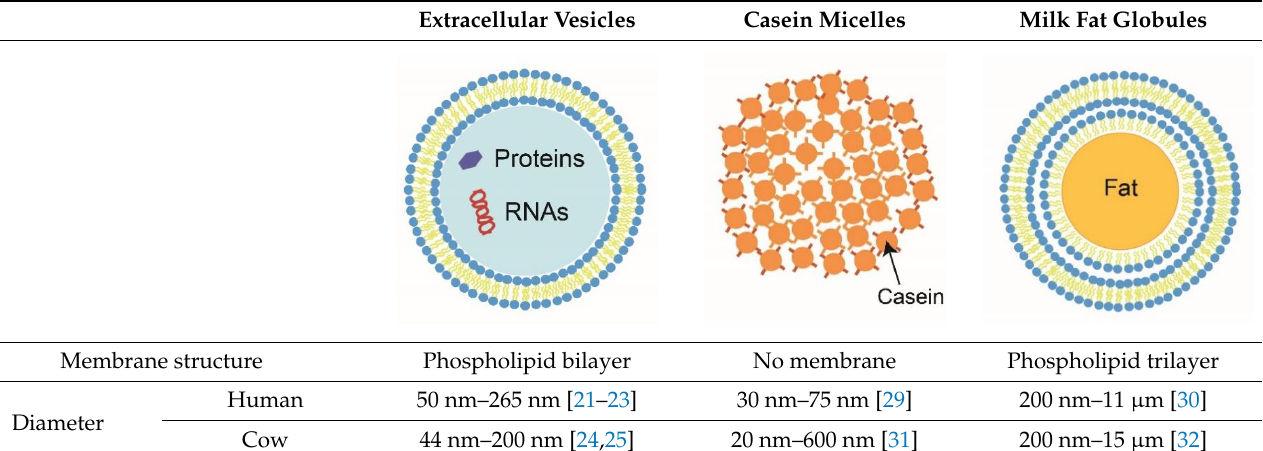
Table 1. Particles present in milk.